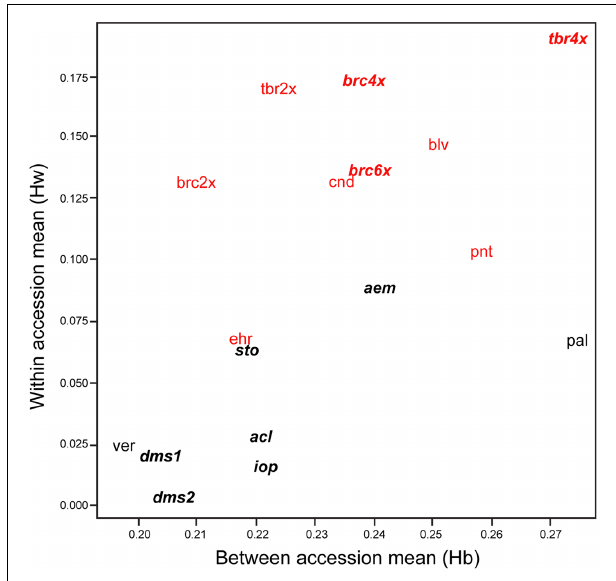
FIGURE 1 | Within ( H w ) vs. between ( H b ) species diversity of the accessions examined here. Species and accession codes refer to Table 1 and the data point lies under the center of the code. Polyploid species are shown in bold italic. Self-compatible species are shown in black and self-incompatible in red. allotetraploid, S. stoloniferum shows considerably more diversity than S. acaule . The allopolyploid 2EBN S. × aemulans is an